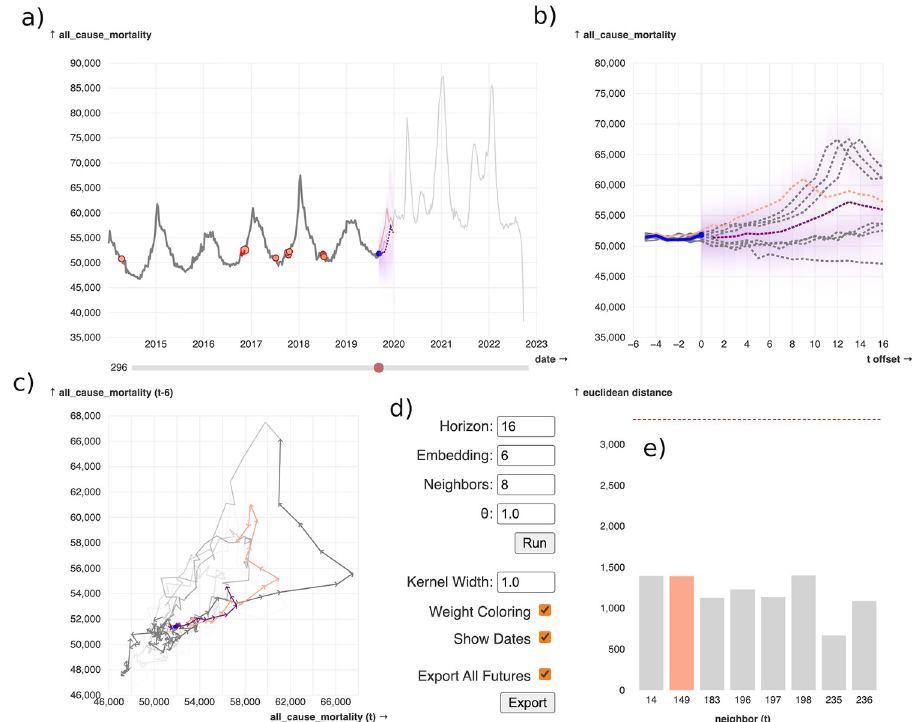
Fig 1. Screenshot of the tool, available at https://episphere.github.io/forecast. The example data depicted here is all- cause mortality from the Centers of Disease Control and Prevention (CDC). The user can also upload their own data or point the tool to data at a URL. a) The chronological time series, which shows the data accompanied by relevant information from the method. The blue dot is the current point, which is configurable by the user using the time-slider below the plot. The red dots are the nearest dynamic neighbors; their color is proportional to the respective neighbor’s weight. The purple shading to the right of the current point is the forecast area, a continuous combination of the neighbors’ futures. Darker areas in the forecast area are higher weighted, meaning they occur in more or higher weighted neighbors’ futures. The purple dashed line is drawn by joining the point forecasts in the forecast horizon; the point forecasts are a weighted average of the neighbors’ futures. b) An offset time-series plot which shows each of the neighbors and their futures, all offset to be on top of each other. This plot is useful for directly comparing the embedded neighbors and their futures. c) A phase-space plot, useful for inspecting dynamic patterns in the data (such as cycles). The phase space plot also clearly shows when the data has entered a new dynamic space, a case in which the EDM method will be less useful. d) Hyperparameters for the methods used by the tool, as well as a couple of additional visual options. e) A bar plot showing the distance of each neighbor to the current embedded point. This is useful for seeing explicitly which neighbors are closest, as well as seeing how that relates to their assigned color across the plots. The dashed line is the mean of all neighbors up to the selected current point in time. If a user hovers over one of the neighbors in any of the plots, then it is highlighted in all other plots. This allows the user to gain an immediate and concurrent sense of several aspects of the